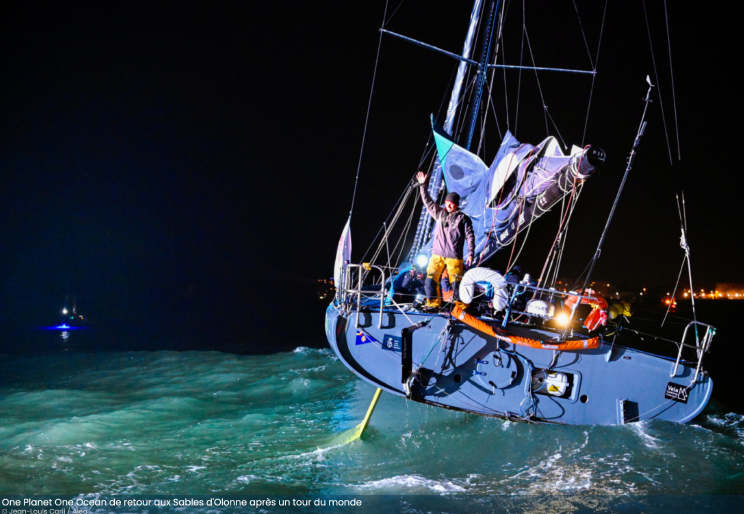
Figure 1. Sailing racer Dídac Costa onboard the One Planet One Ocean, an Open 60 sailing boat arriving to Les Sables d’Olonne after a world tour during the ninth edition of the Vendée Globe race. Image from www.vendeeglobe.org, last accessed on 5 August 2022, with copyright of Jean-Louis